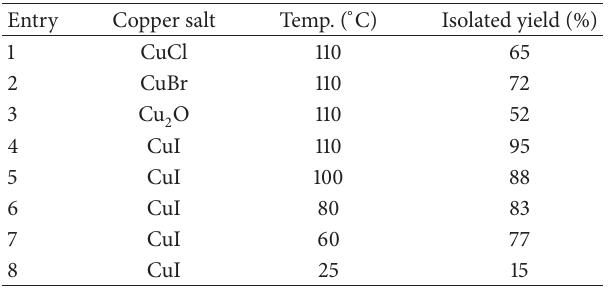
Table 1: Optimization of the reaction temperature and screening of copper sources a